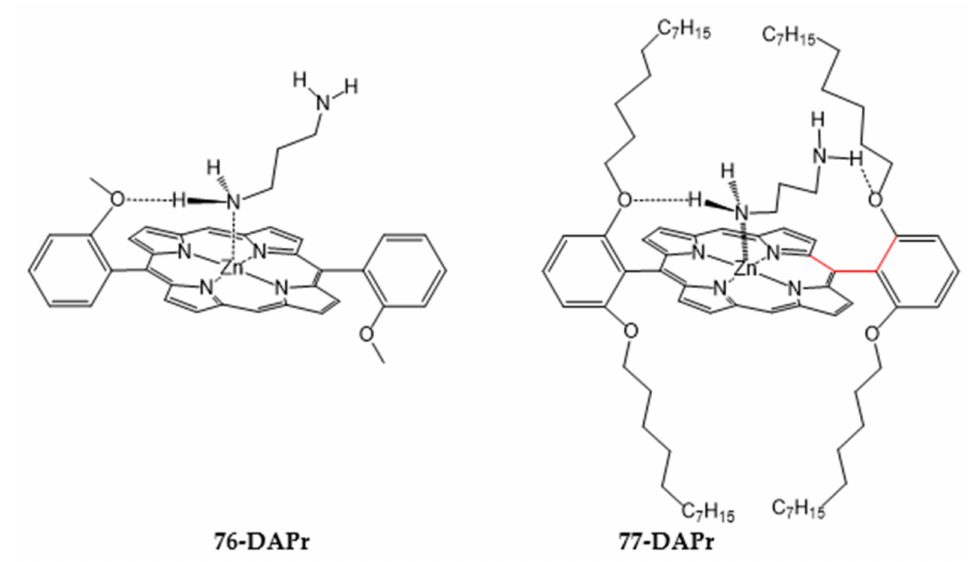
Figure 17. Complexes of dialkoxy-substituted porphyrinates 76 and 77 with DAPr